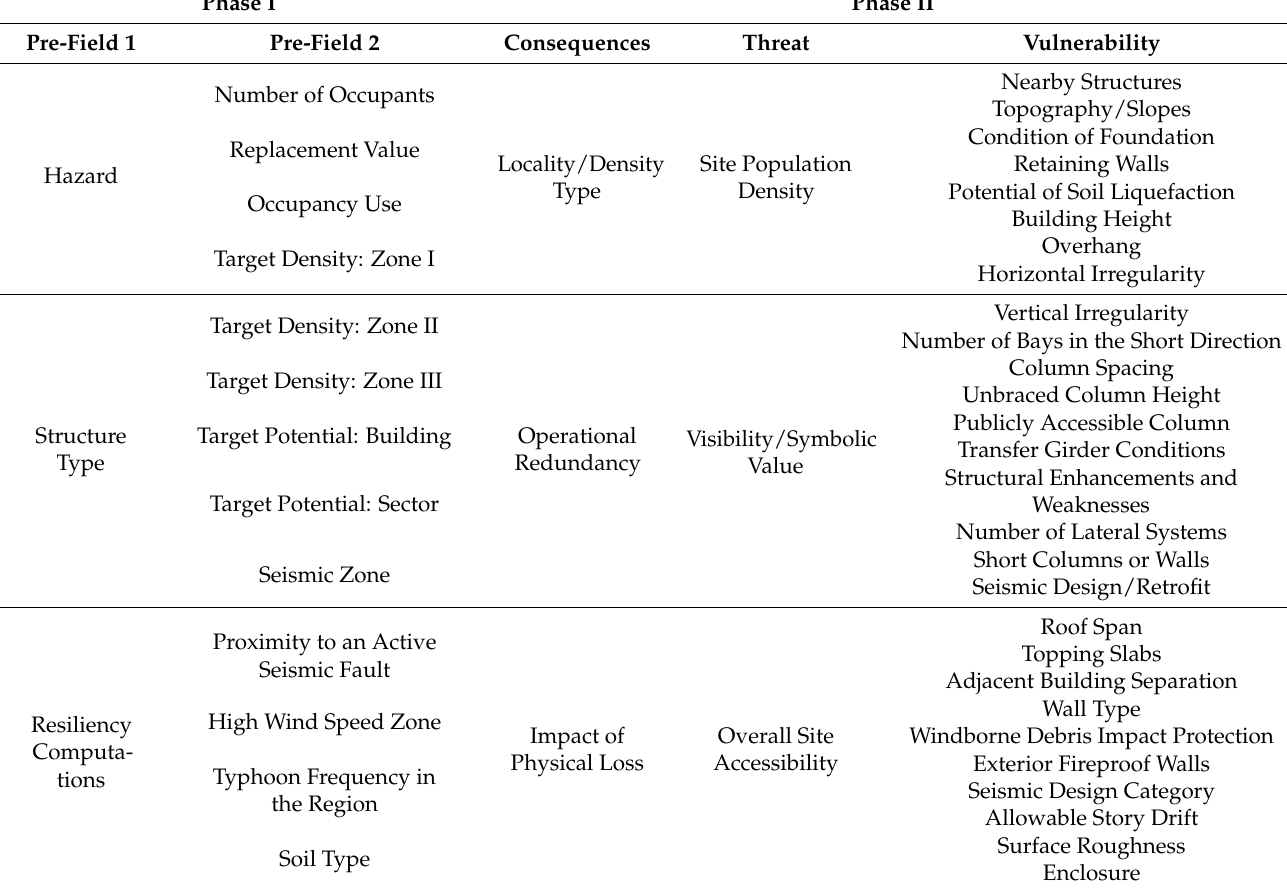
Table 1. K-RVS of detailed components.